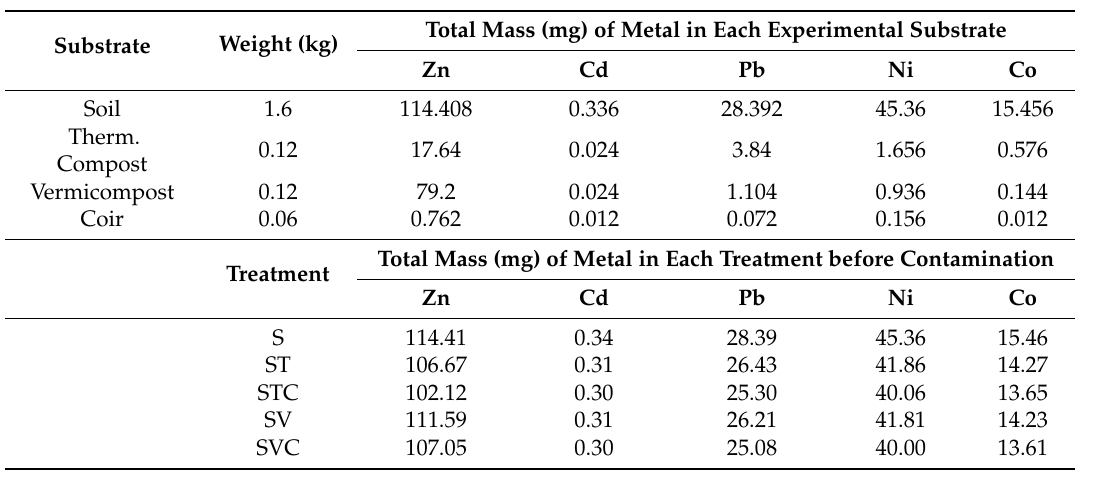
Table A1. Total mass of metal in each substrate used in the experiment and calculated total mass of metals in the different treatments before